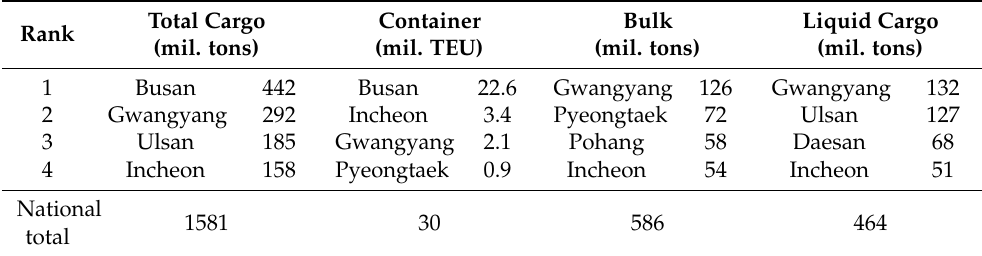
Table 1. The rank of ports by cargo in Korea in 2021.